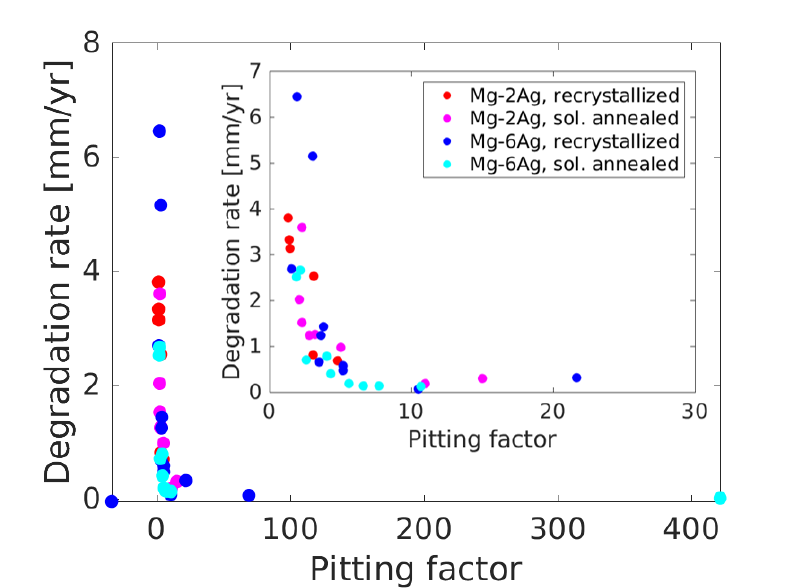
Figure 5. Correlation between degradation rate and pitting factor for all alloys and treatments at all time points. The inset displays the correlation after removal of the